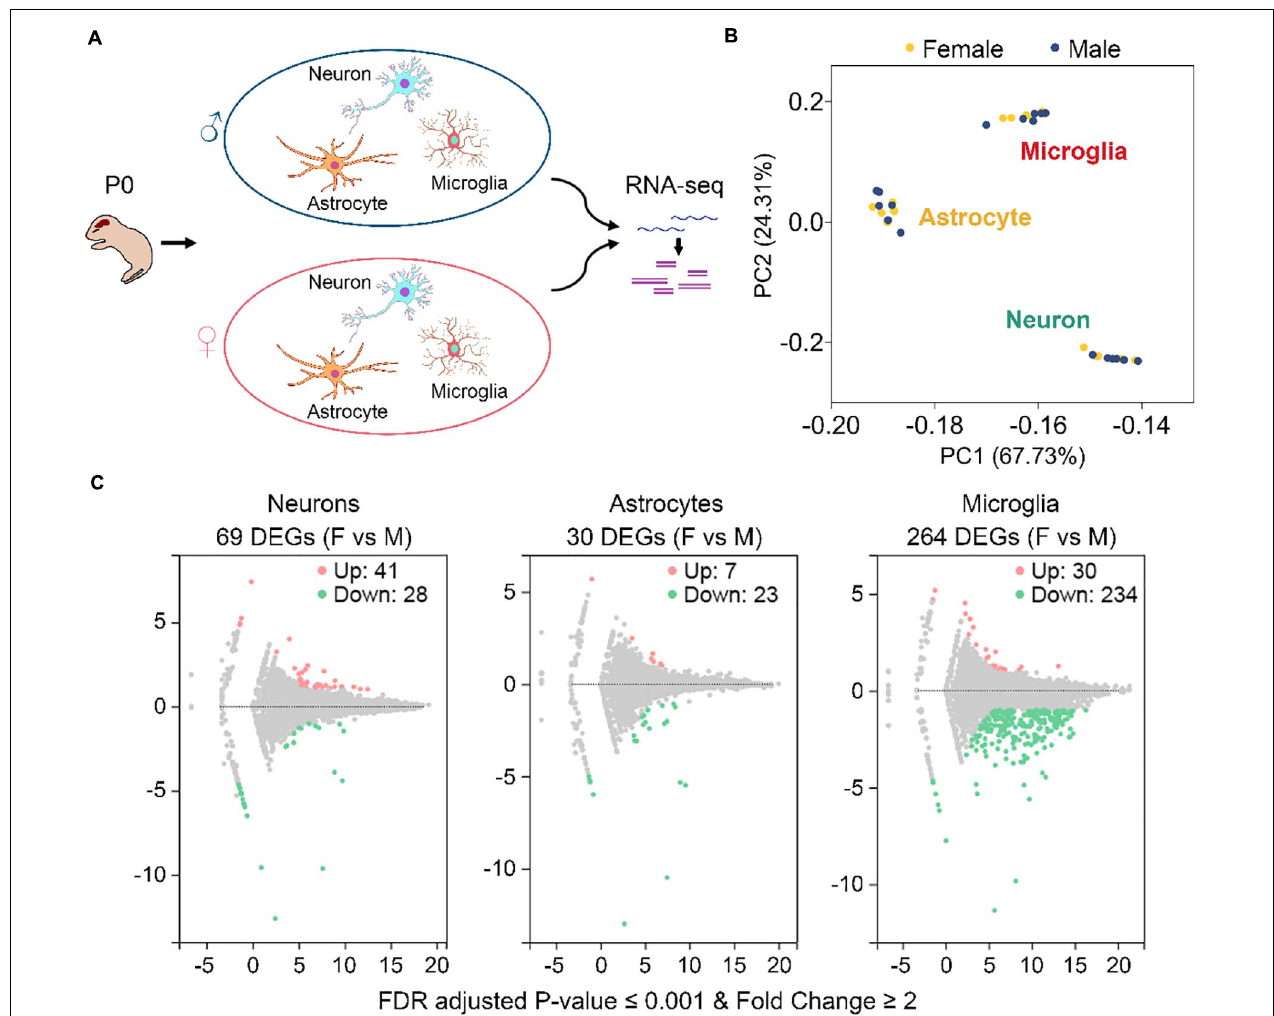
FIGURE 1 | Identification of sexually dimorphic genes in neurons, astrocytes, and microglia. (A) Sample preparation strategy. Primary neurons, astrocytes, and microglia were isolated from the same postnatal day 0 (P0) male and female mice and cultured in vitro . RNAs were extracted from individual cultures and subjected to RNA sequencing. For each cell type, n = 6 males from two litters and n = 6 females from the same two litters. (B) PCA analysis of gene expression depicts three discrete subsets corresponding to neuron, astrocyte, and microglia samples, respectively. Yellow and blue dots represent female and male samples, respectively. (C) Volcano plots of gene expression change between female (F) and male (M) in neurons, astrocytes, and microglia. Pink and green dots represent genes that are expressed significantly higher and lower in females vs. males, respectively. Benjamini-Hochberg method, Storey and Tibshirani’s approach, false discovery rate (FDR) adjusted P -value ≤ 0.001, fold change ≥ 2. A total of 69, 30, and 264 differentially expressed genes (DEGs) were identified in neurons, astrocytes, and microglia,